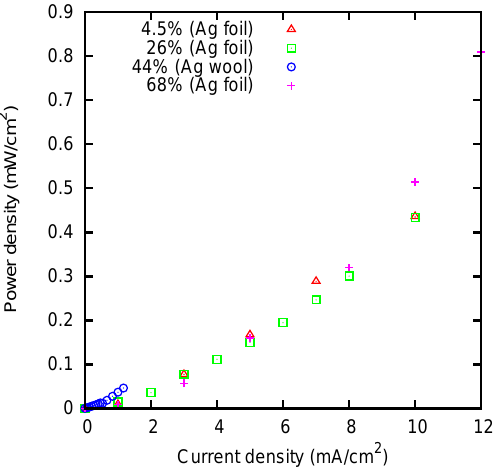
Figure 9. The average dissipated power density at the AgCl/Ag electrode. The conditions are the same as Figure